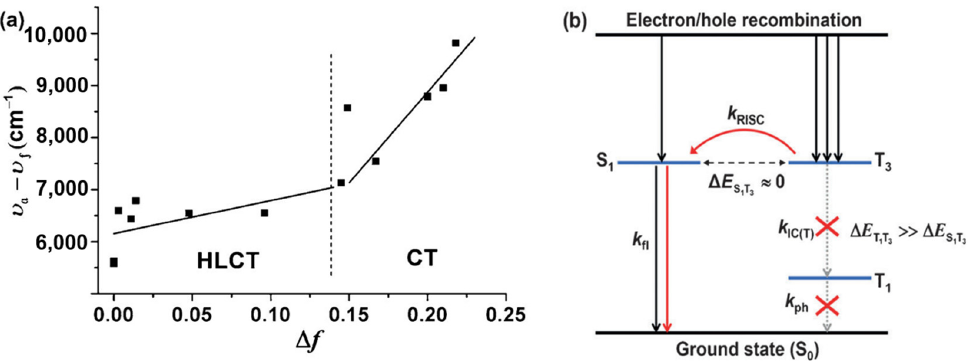
Figure 16. ( a ) Linear correlation of the orientation polarization ( ∆ f ) of solvent media with the Stokes shift ( v a - v f ; a: absorbed light; f: fluorescence) for M42 . ( b ) Model for exciton relaxation in the EL process. RISC: reverse intersystem crossing; IC(T): internal conversion between the triplet states; fl: fluorescence; ph: phosphorescence (adapted from ref. [140]).